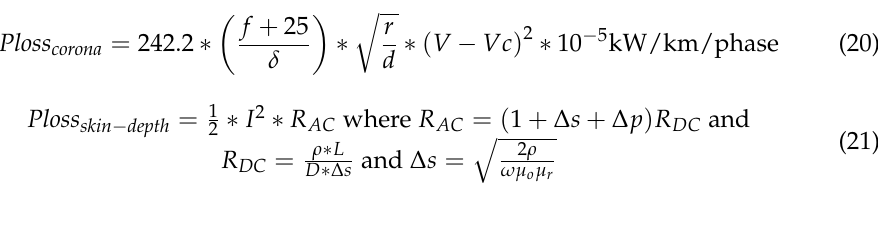
Figure 11. Losses for different MVAC and MVDC voltages, with shaded regions indicating the power and distance range, where DC transmission results in lower losses. The dotted lines represent the limits of the transmission scheme (maximal current or maximal losses) [79].